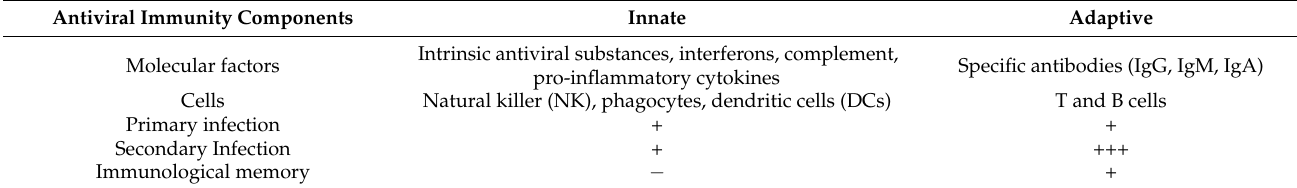
Table 2. Effectors of innate and adaptive antiviral